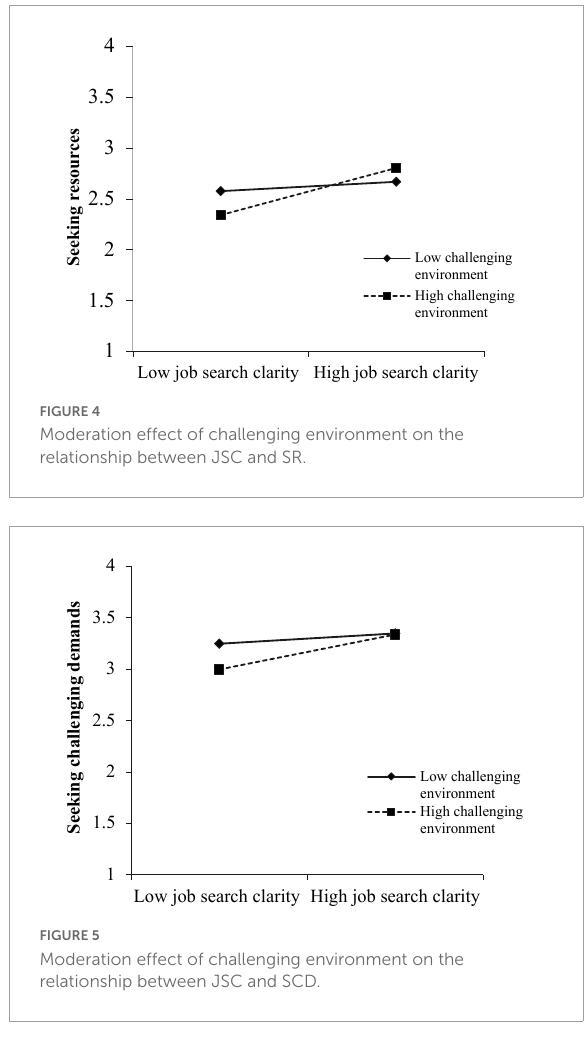
FIGURE5 Moderation effect of challenging environment on the relationship between JSC and